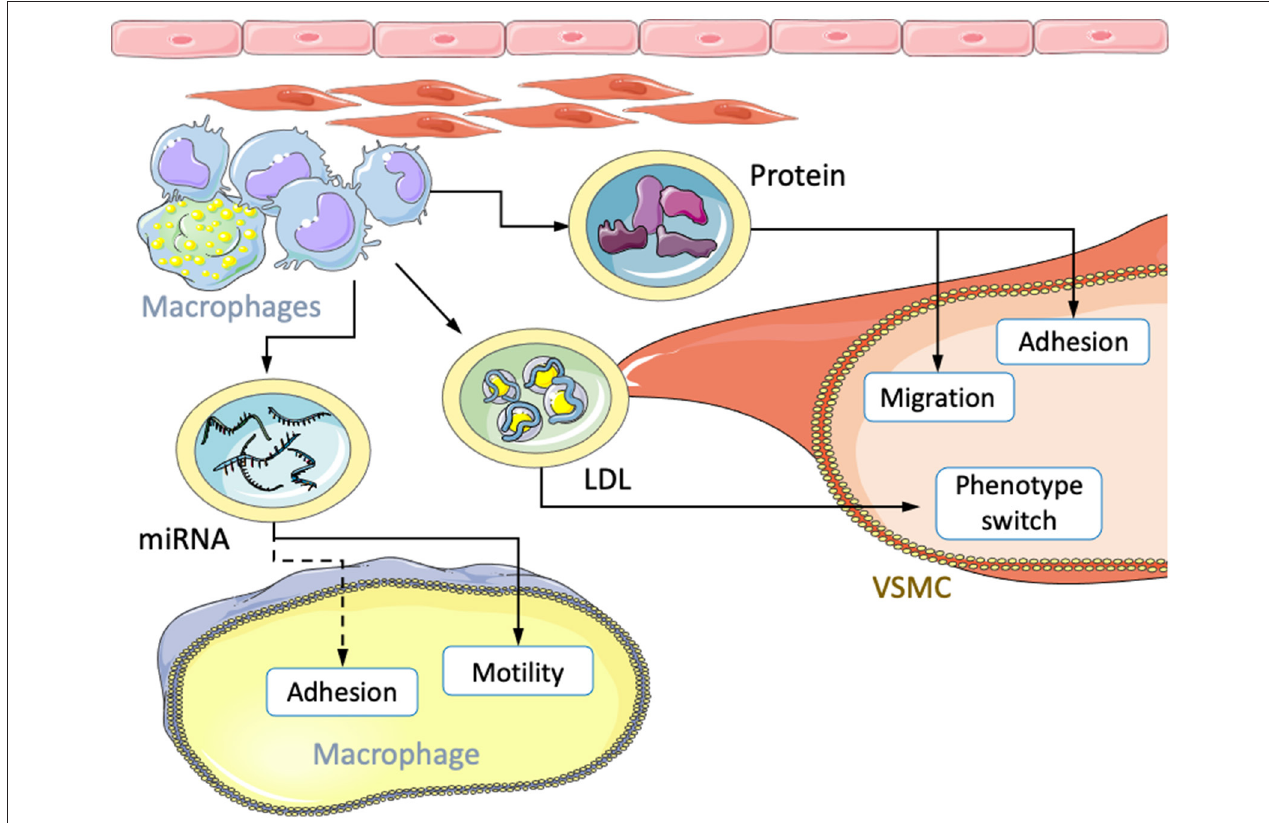
FIGURE 2 | Transfer of atherosclerotic factors via extracellular vesicles. Macrophages transfer miRNA, LDL, and protein cocktails to other macrophages and VSMCs. The received content leads to changes in migration, motility, adhesion and phenotypic modulation.